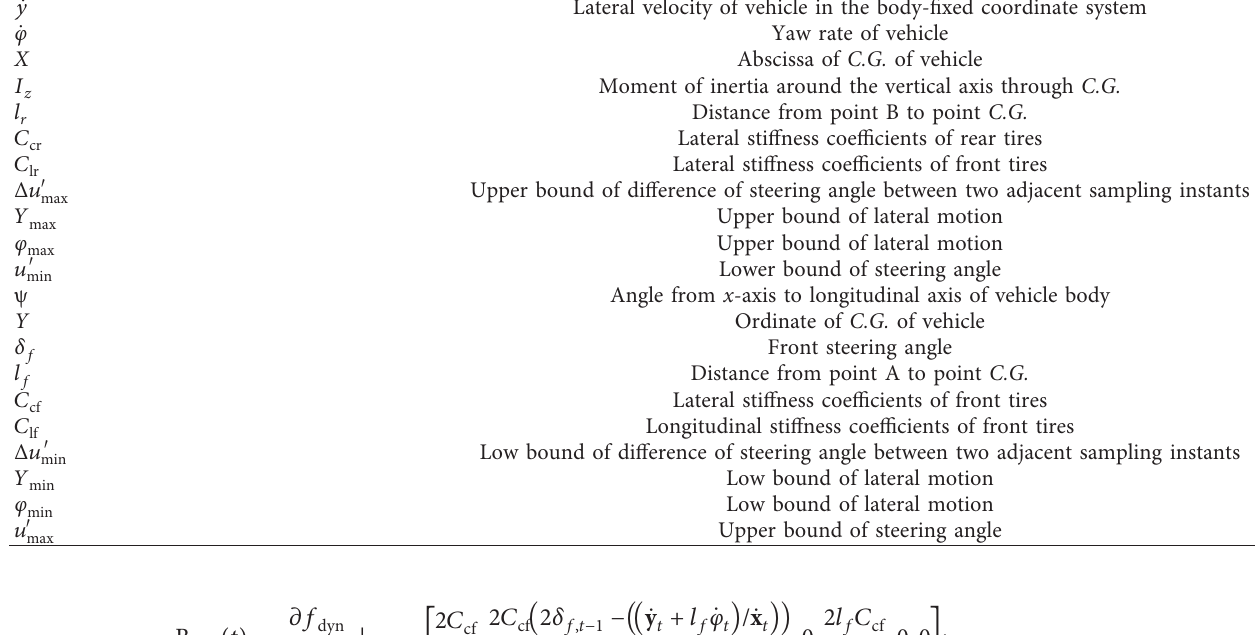
Table 6: Parameters in the lateral dynamics controller design. Lateral velocity of vehicle in the body-fixed coordinate system _